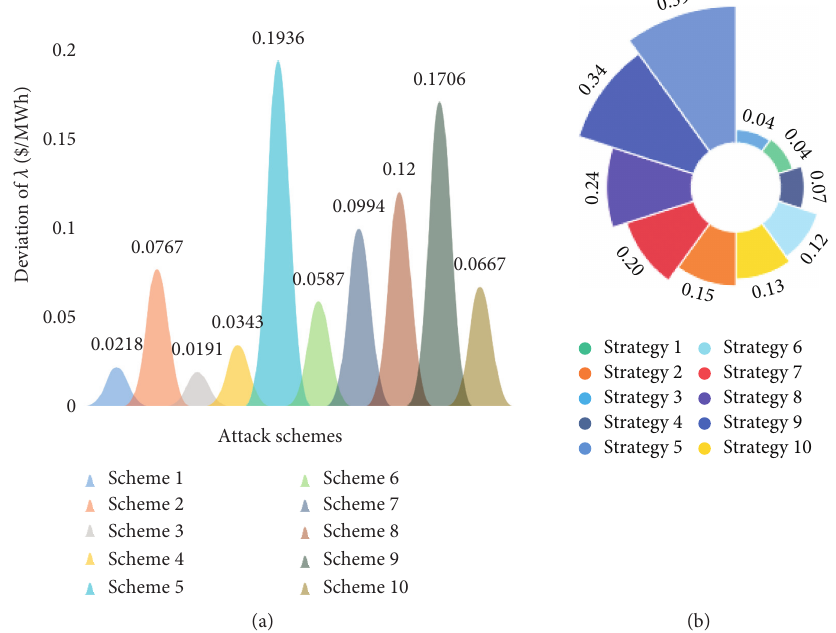
Figure 7: The comparison for different attack strategies. (a) Deviation of incremental cost in the attacks’ situation compared to the ideal situation. (b) The effect of attacks under different attack